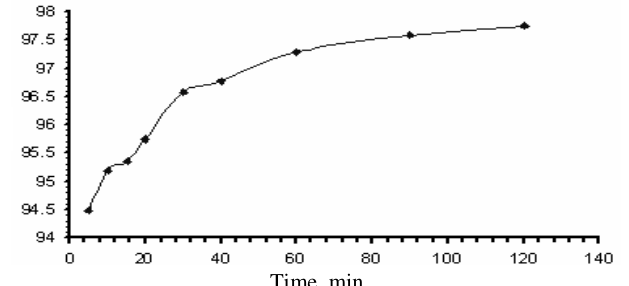
Figure 4. Effect of contact time on the percent removal of Cu(II) onto PFA.